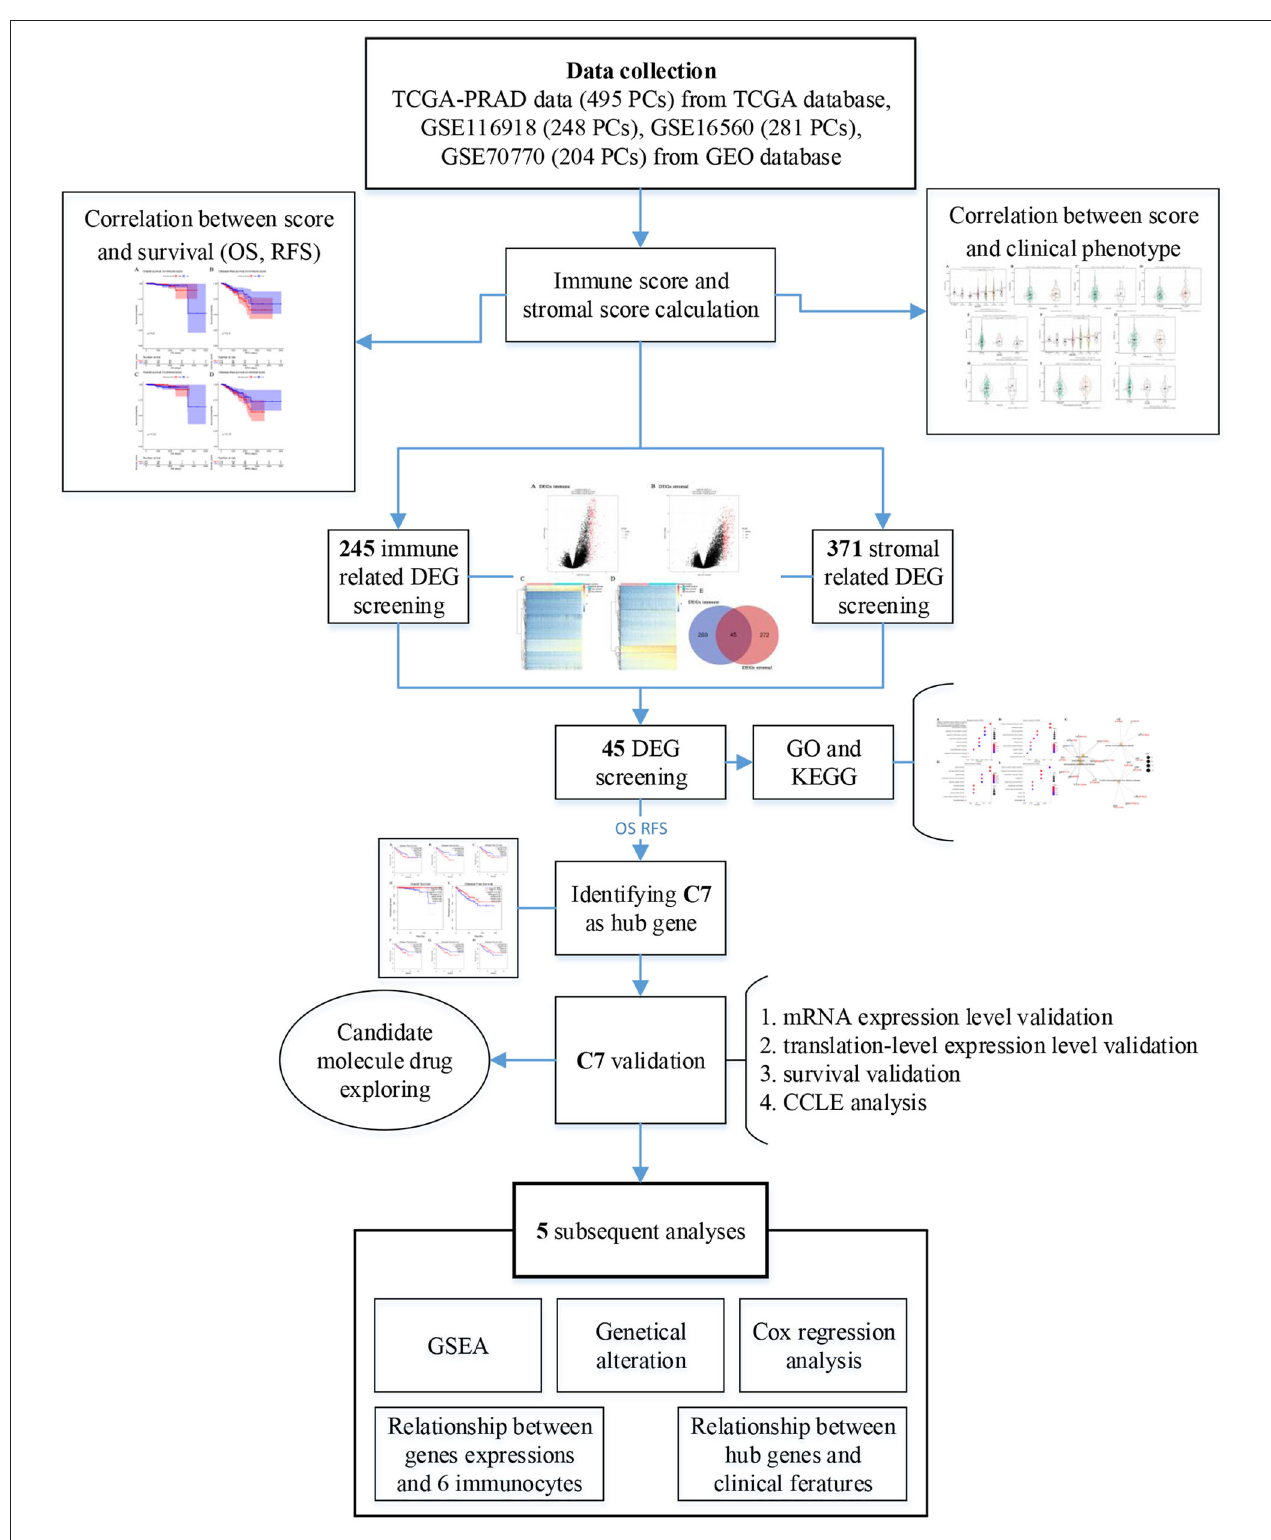
FIGURE 1 | Flow diagram of data preparation, processing, analysis, and validation in this study.